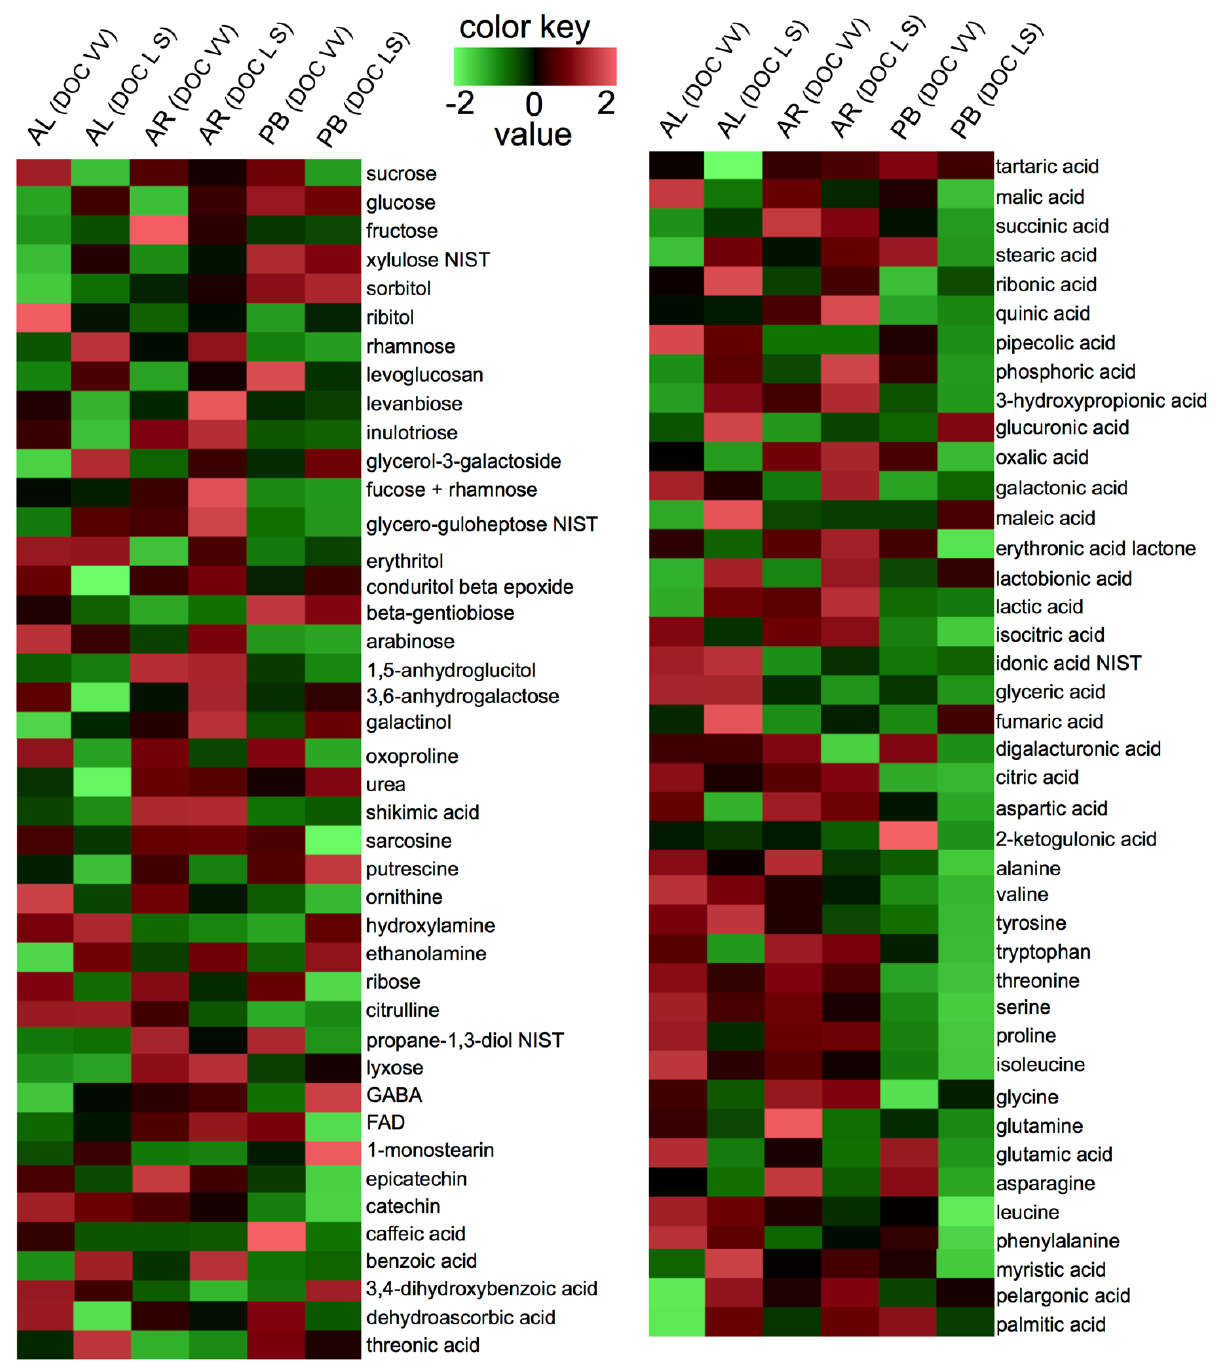
Figure 2. The heatmap of metabolite changes in mature grape berries from Alvarinho (AL), Arinto (AR) and Padeiro de Basto (PB) varieties cultivated in the DOC VV and DOC LS regions. Values were centered and scaled in the row direction to form virtual colors as presented in the color